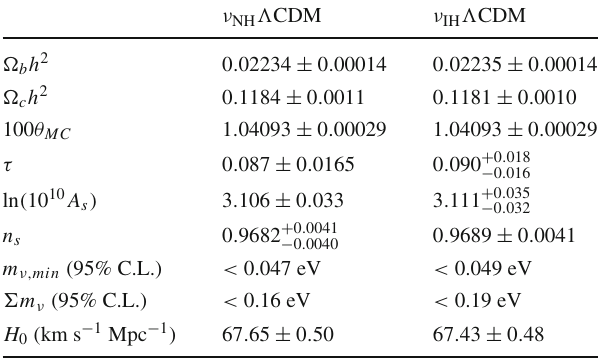
Fig. 2 The normalized H ( z ) plot in the (cid:2) CDM model, w CDM model the 68% confidence ranges of the w CDM model and w 0 w a CDM model and w 0 w a CDM model. The gray band represents the 68% confidence allowed by P15+BAO, respectively. The black and orange error bars denote the Hubble parameters measured by HST (named R16) in [7] range in the (cid:2) CDM model allowed by P15+BAO. The ranges between and the Ly α forest of BOSS DR11 quasars (named Ly α Forest) in [20] the two blue dash-dotted lines and the two red dashed lines represent Table 2 The 68% limits for the cosmological parameters in the ν (cid:2) CDM model and the ν (cid:2) CDM model from P15 + NH IH